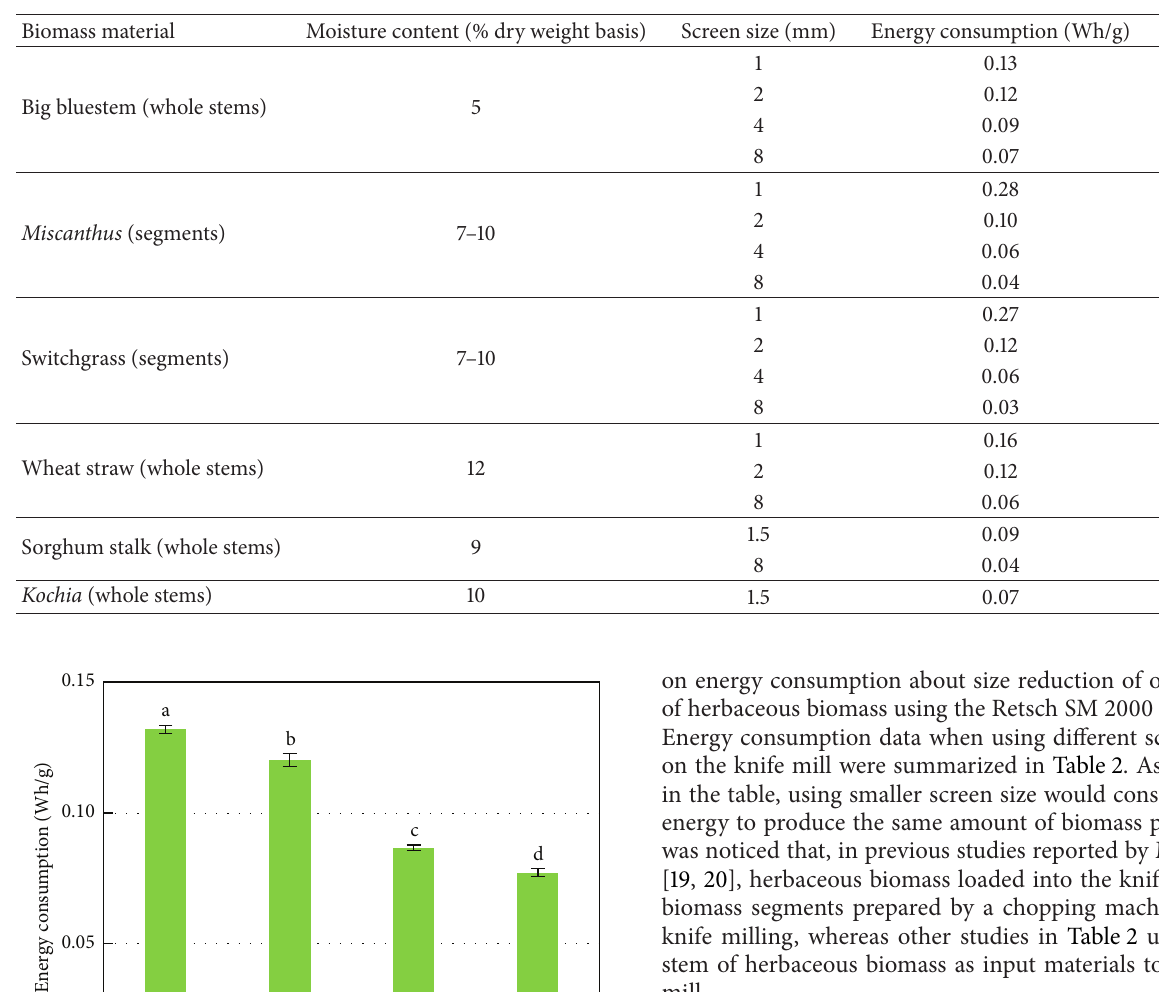
Table 2: Energy consumption in biomass size reduction using Retsch SM2000 knife mill.